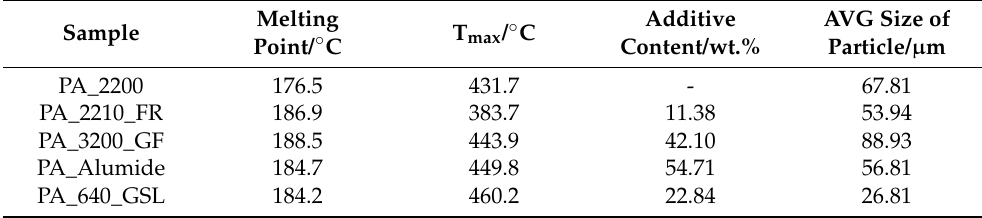
Table 4. Results for DTA-TGA measurement and size